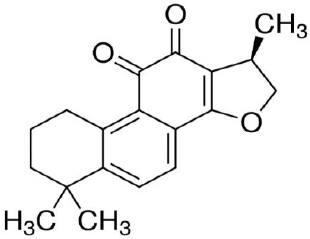
Figure 8. Structure of cryptotanshinone (CTT).